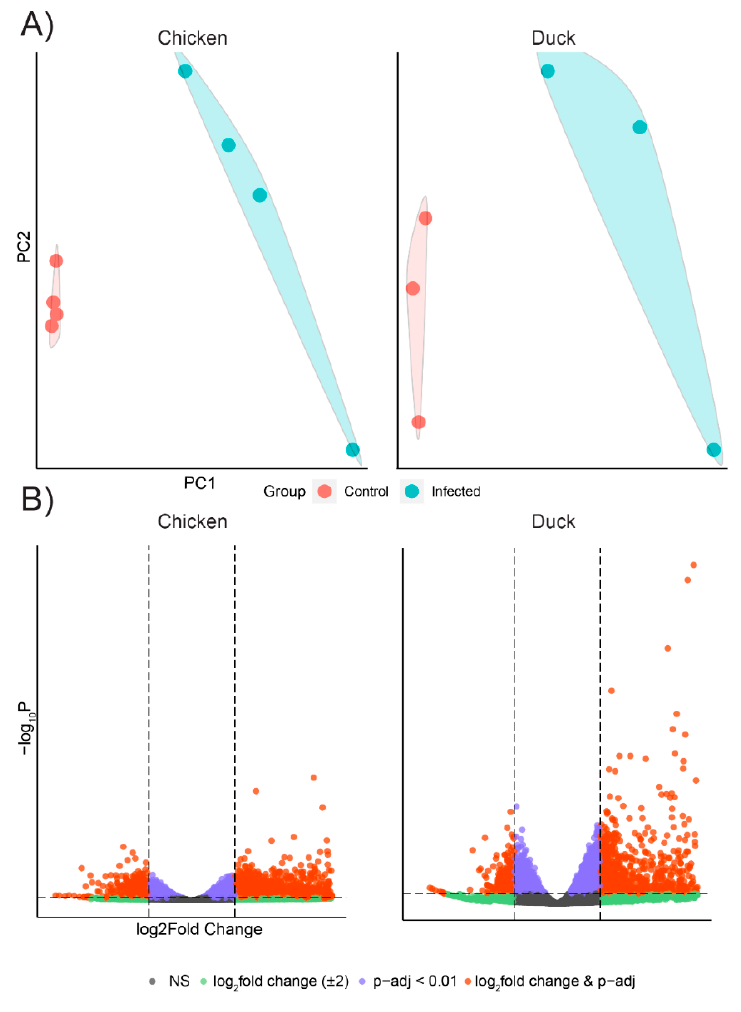
Figure 1. Chicken and duck endothelial cells have a different transcriptional response to HPAIV in vitro. RNA Seq analysis was performed 12 h post-infection on avian aortic endothelial cells inoculated with HPAI H5N1 (MOI 1). ( A ) Principal Component Analysis (PCA) plots of gene expressions based on RNAseq data. ( B ) Volcano plots showing differentially expressed genes between virus and mock-infected cells. DEGs ( q -value = 0.01, log2fold enrichment of 2) are shown in orange. DEGs with a fold change enrichment of 2 (but q -value > 0.01) are shown in green. Genes that have q -value < 0.01 but not log2fold enrichment of 2 between the two treatment groups are shown in purple. NS = not significant (non-significant genes are shown in grey points).